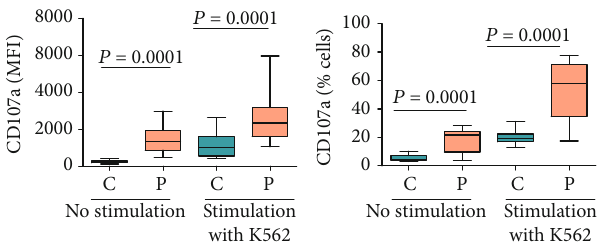
Figure 7: The surface expression of CD107a on CD 56bright/dim NK cells in CD patients vis-à-vis healthy controls with and without prior stimulation with K562. The panels show MFI of CD107a expression and percentages of CD107a expressed in NK cells. The box and whisker plots indicate median, interquartile ranges, and p values from ten treatment-naïve CD patients and the same number of healthy control